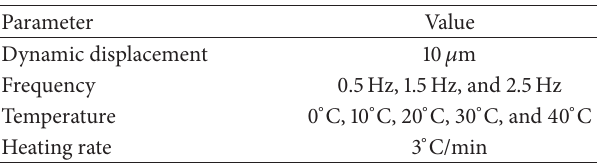
Table 1: Working parameters of the dynamic temperature scan.